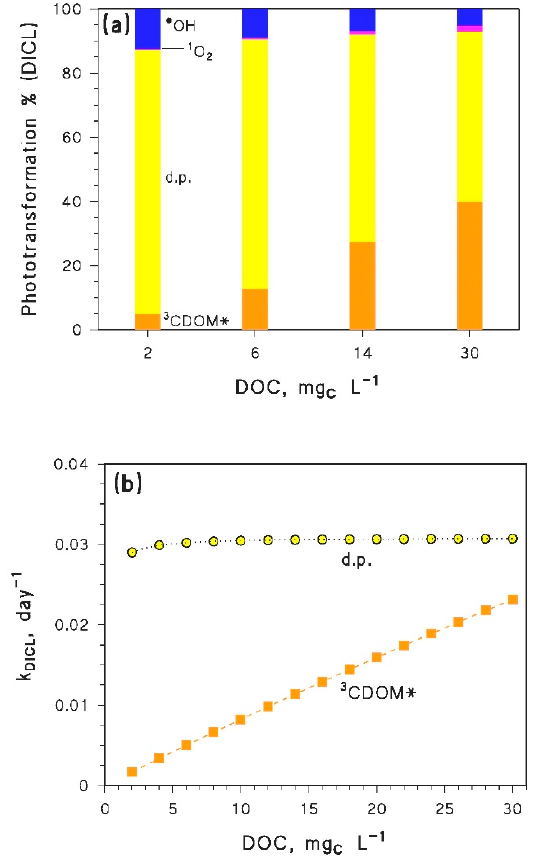
Figure 5. ( a ) Modeled contributions of • OH, 1 O 2 , 3 CDOM* and the direct photolysis (d.p.) to the photodegradation of DICL, for different values of the DOC. ( b ) DOC trends of the first-order photodegradation rate constants of DICL, accounted for by direct photolysis (d.p.) and 3 CDOM*. In both cases, it was DOC × d th = 45 m mg C L − 1 .